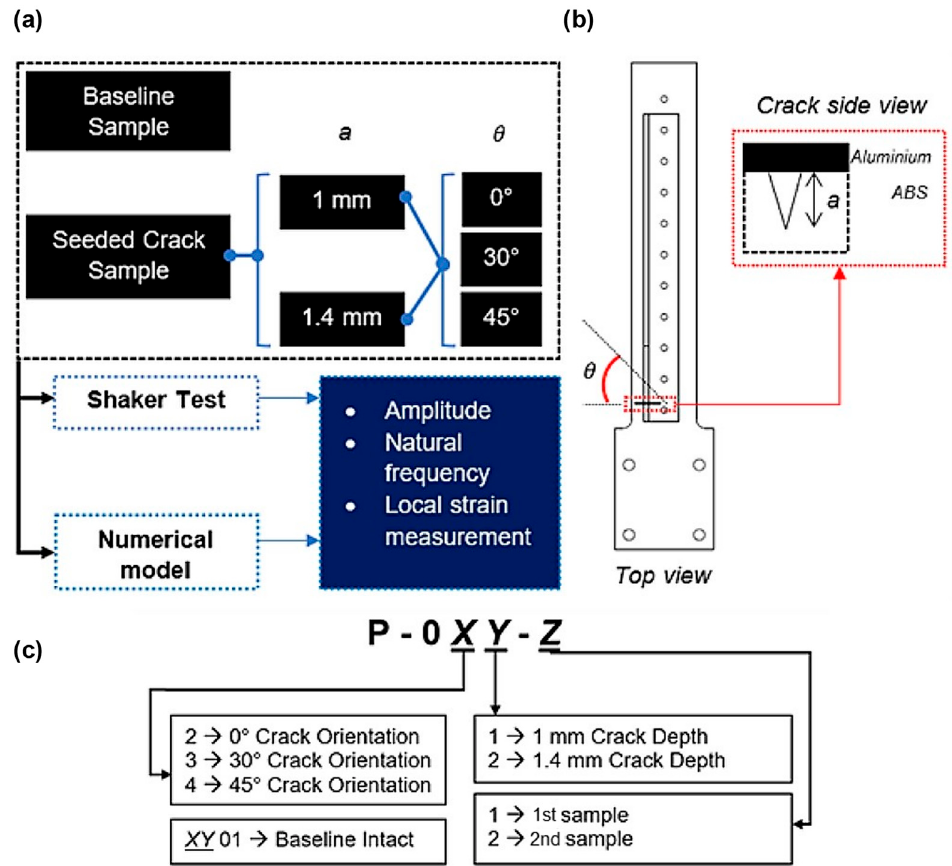
Figure 1. ( a )Damage scenario, ( b ) crack location on the sample, and ( c ) sample codi fi cation.